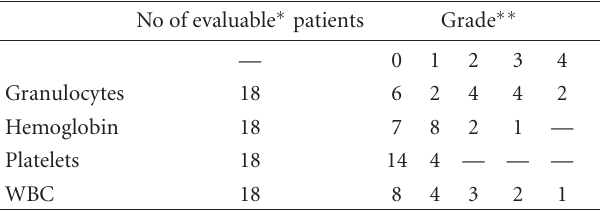
Table 4: Treatment-related hematologic toxicity (worst by patient). No of evaluable (cid:0) patients Grade